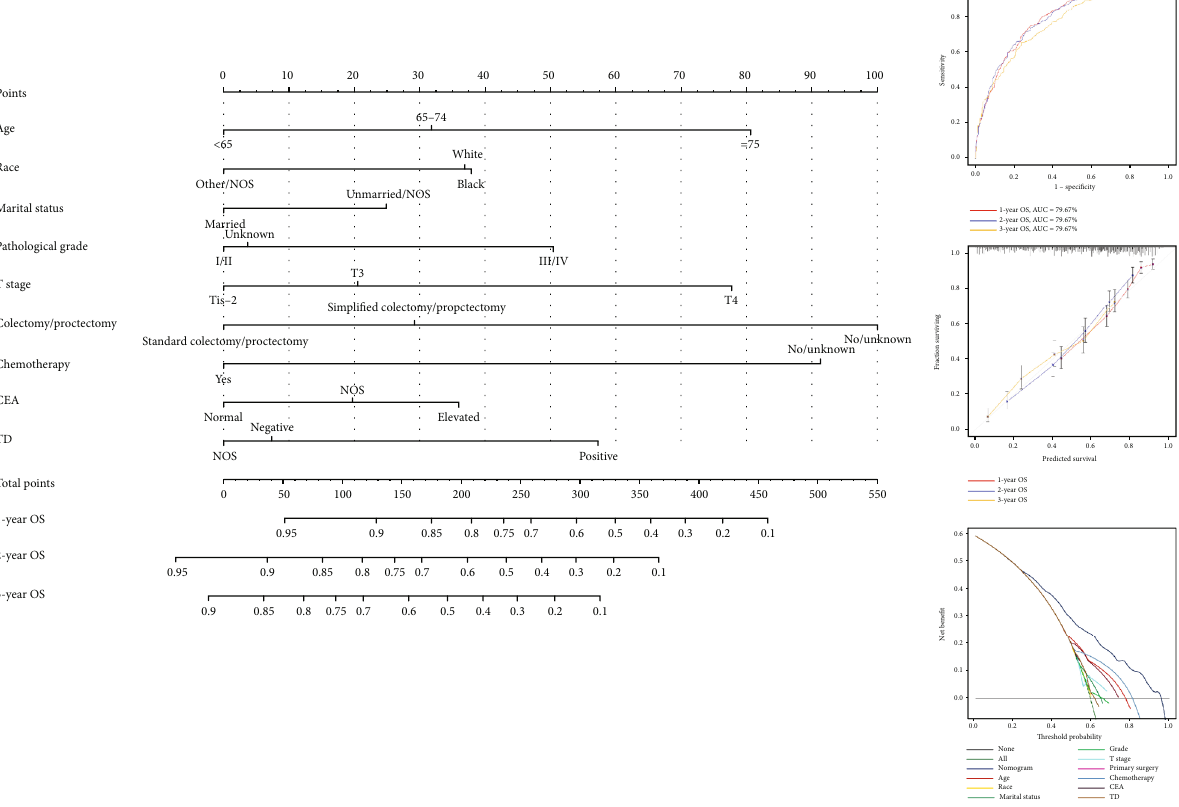
Figure 2: The impact of each prognostic factor on survival for patients with